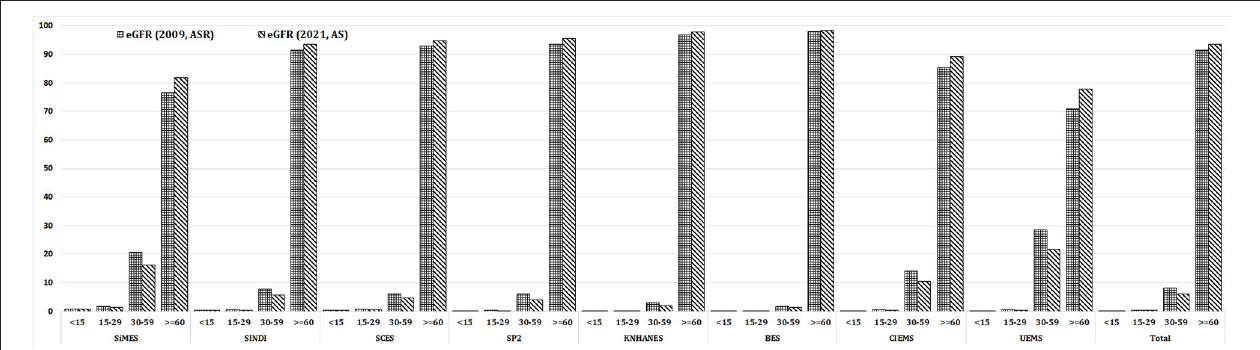
FIGURE 1 | Prevalence of eGFR Categories in the eight Asian study cohorts.